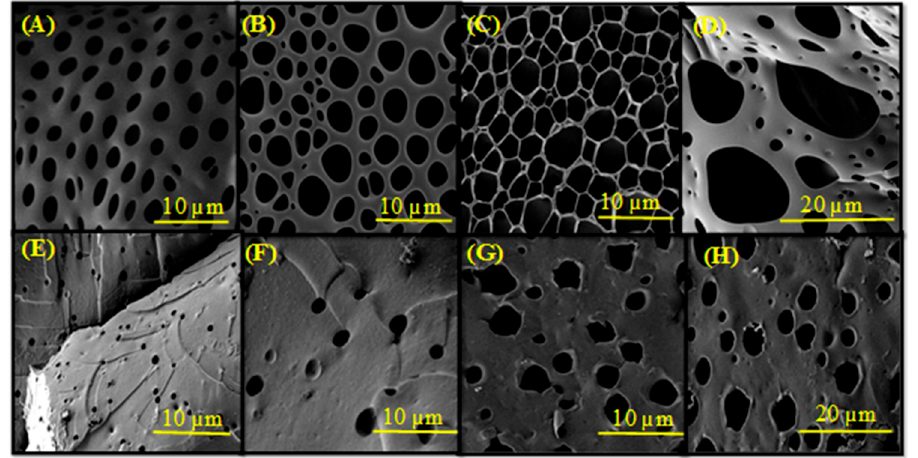
Figure 1. Representative solid state 13 C CP/MAS NMR spectra of C200 gel before (A) and after (B) acetyl (-OAc) group deprotection.